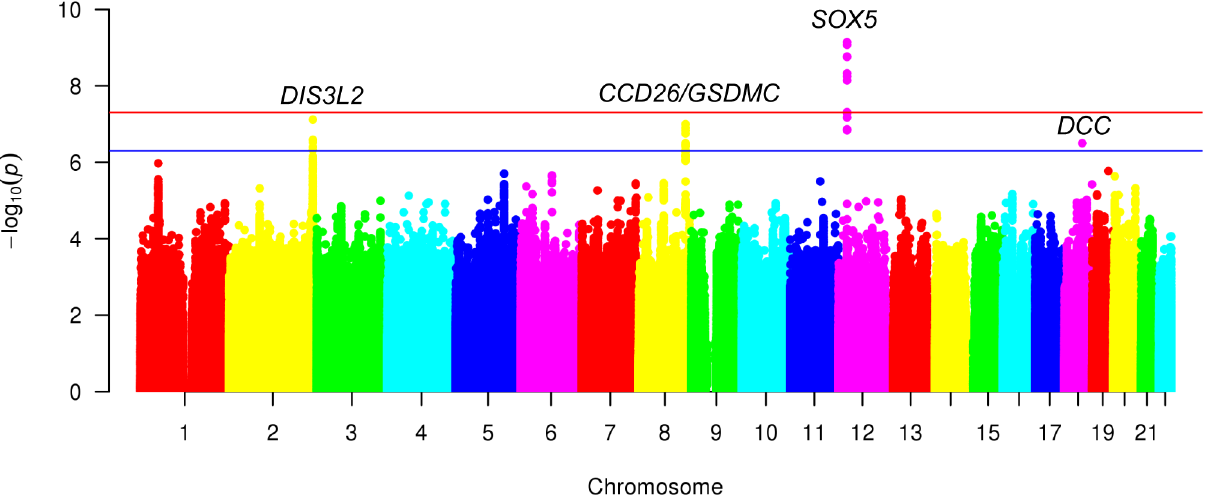
Fig 1. Manhattan plot for meta-analysis (discovery) of GWAS of chronic back pain (n = 158,025). GWAS = genome-wide association study. Results use the linkage disequilibrium score regression (LDSR) intercept as a correction factor. Red line depicts genome-wide statistical significance (P < 5 × 10 −8 ). Blue line depicts suggestive significance (P < 5 × 10 −7 ).